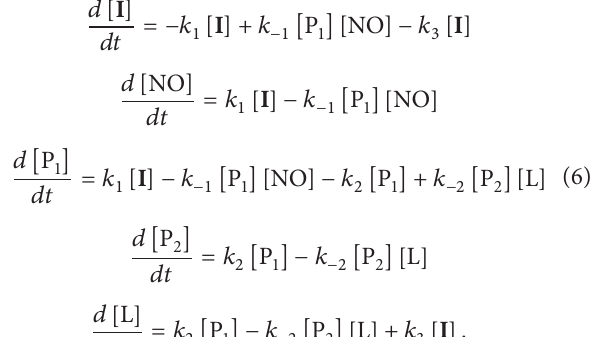
Circles are experimental data. Approximation (theoretical